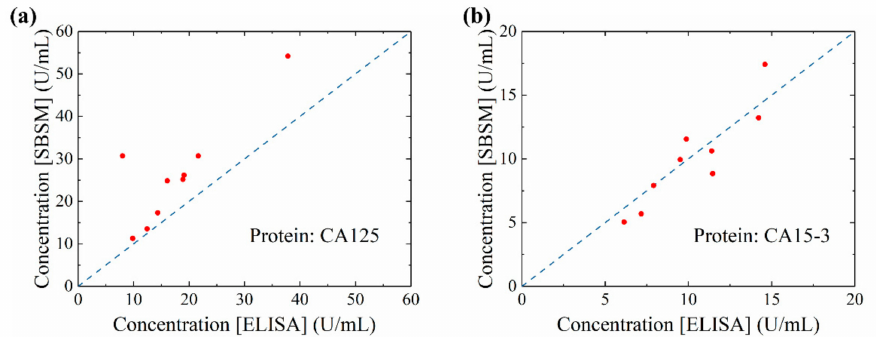
Figure 8. Data comparing results measured by the SBSM and results provided by the hospital. ( a ) The concentration of CA125 measured by the SBSM and ELISA (enzyme-linked immunosorbent assays); ( b )The concentration of CA15-3 measured by the SBSM and ELISA. Blue dash line: reference line where concentrations measured by the SBSM and ELISA were